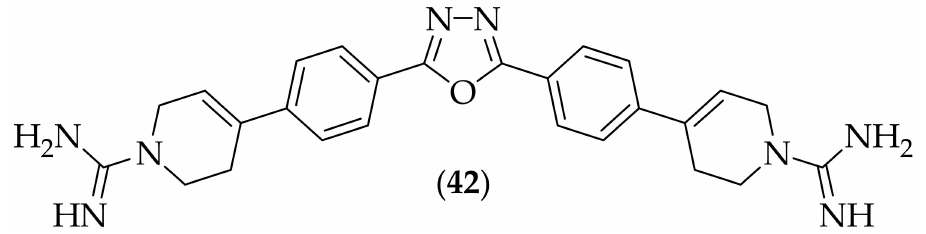
Figure 27. Bis-guanidine containing oxadiazole analog ( 42